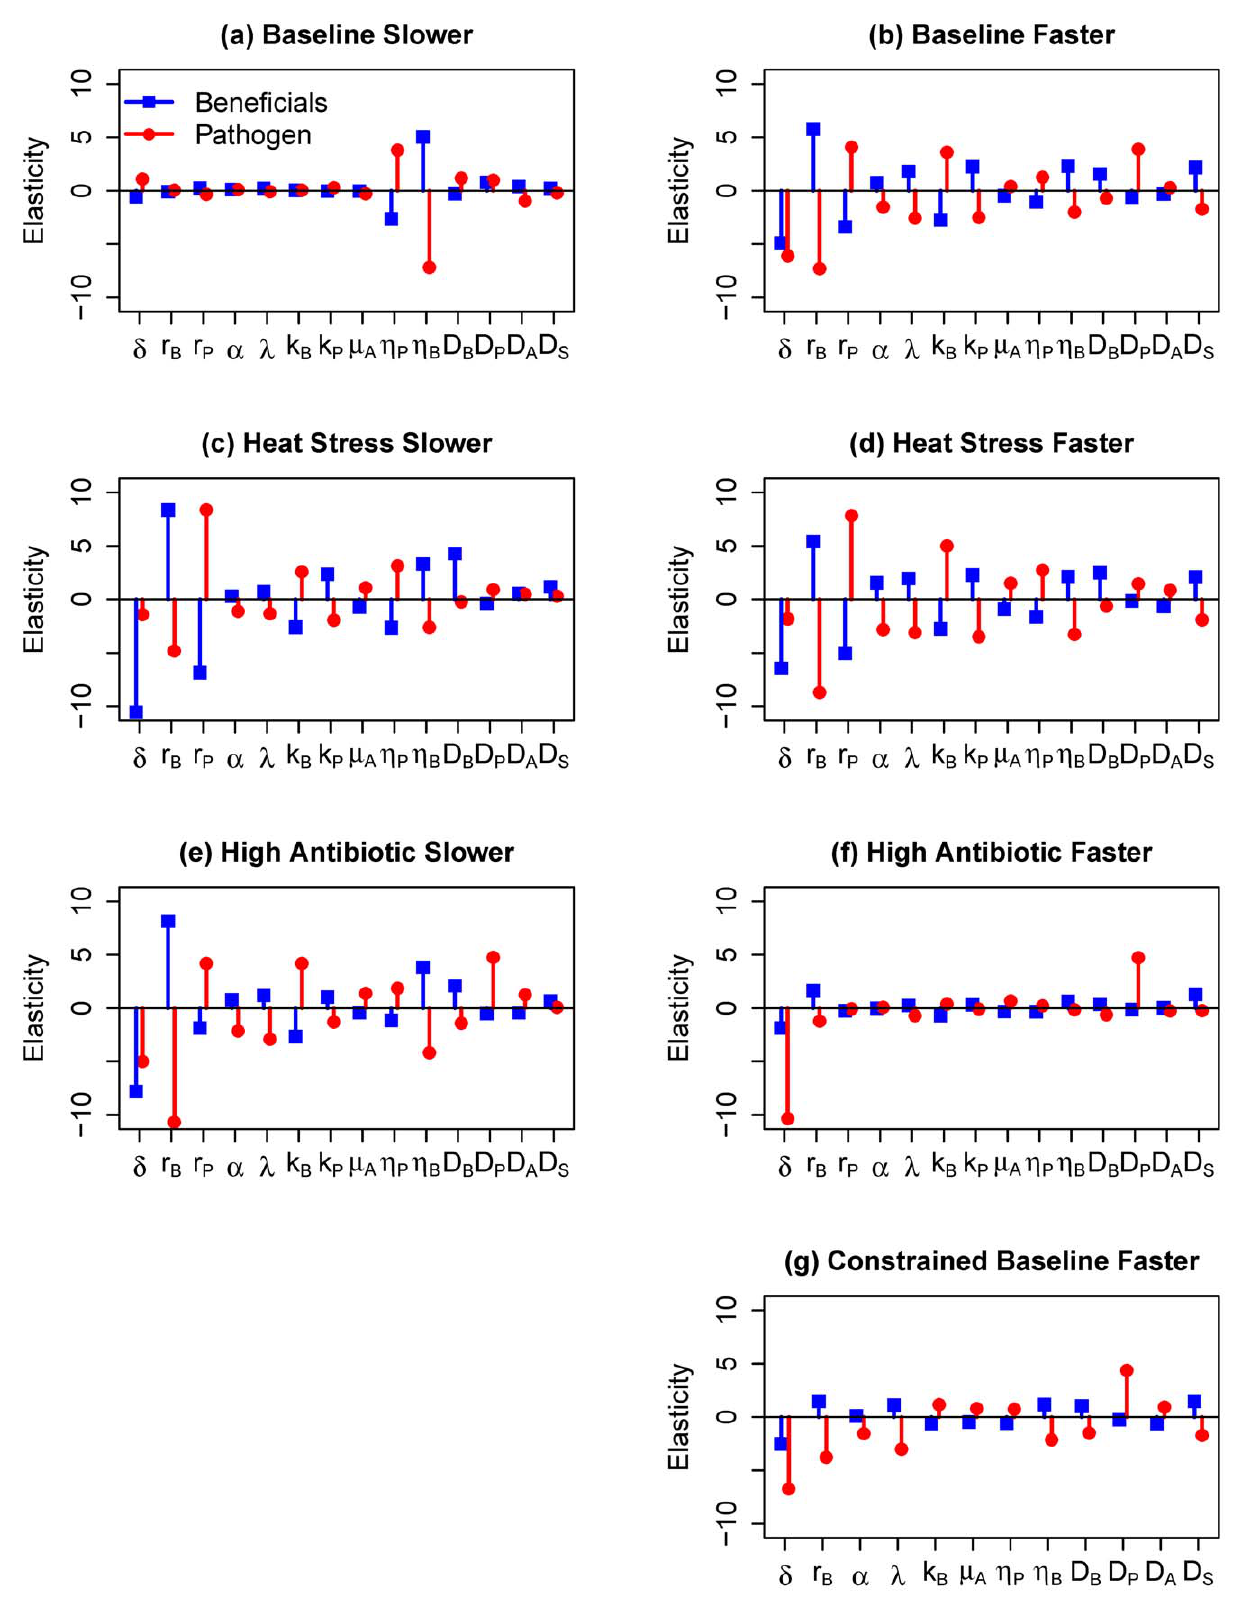
Figure 6. Results of local sensitivity analysis using Latin Hypercube Sampling and multiple linear regression, with parameters allowed to vary by up to 6 50% from their default values. See Text S5 for details on methods; parameters and their default values are listed in Table 1. Results are shown for three scenarios (baseline, heat stress conditions, and high antibiotic efficacy) and two sets of values for potential